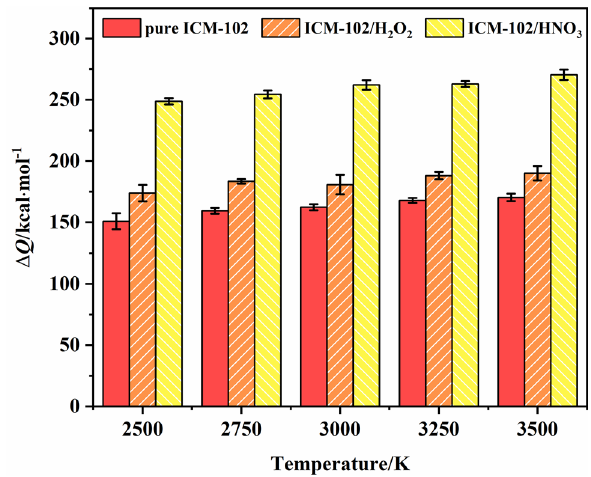
Figure 2. Comparison of the average heat release of each ICM-102 molecule in the pure ICM-102, ICM-102/ H